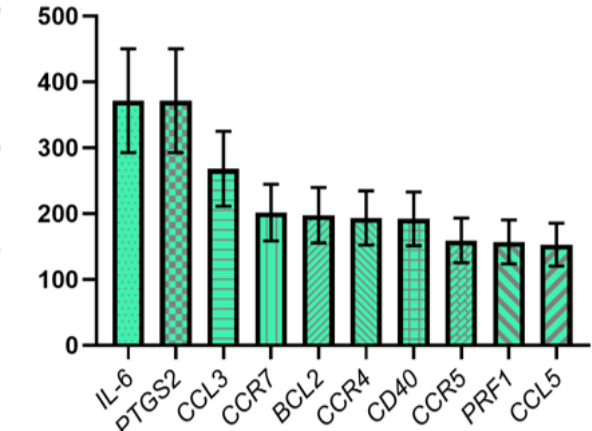
Figure 4. Presentation of the most abundantly expressed genes in screening analysis. Transcripts were distinguished based on their significant expression—over 150% of the control value. All gene expression results were calculated using the 2 - ΔCt equation (according to the reference gene encoding 18S rRNA), n = 12. Table 2. The mRNA expression of pro-inflammatory molecules exclusively presented in ACS pa- tients.